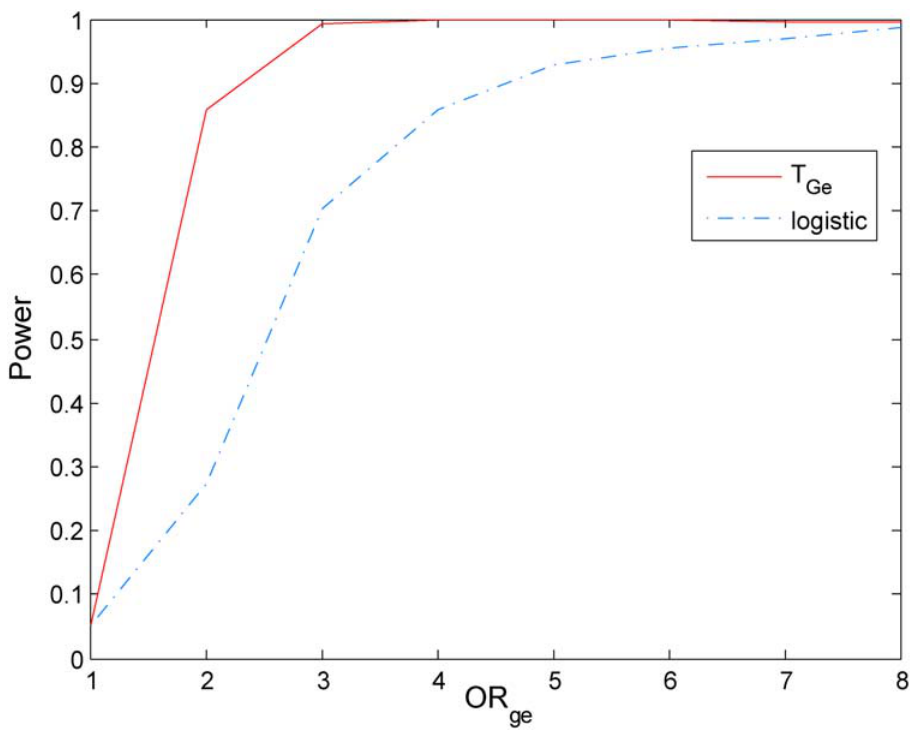
Figure 7. Power of the statistic T I and logistic regression analysis for 500 cases and controls respectively.